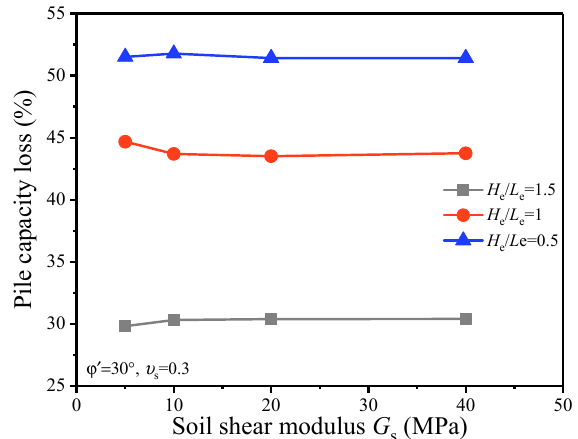
Figure 15. Effects of soil shear modulus on pile uplift capacity loss with various ratios of excavation depth to effective pile length.